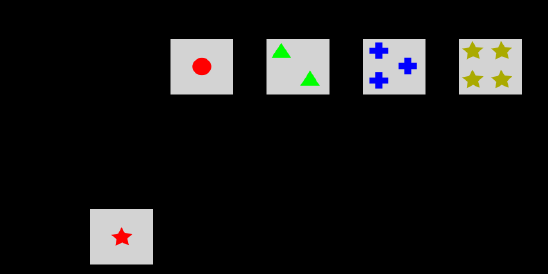
Figure 1. The computerized version of the WCST as offered by PsyToolkit [29]. A standardized collection of computerized cognitive tests. On the top of the image are the four different possible categories. On the bottom is the stimulus card presented to the user. The user is supposed to match the stimulus card to one of the categories by inferring the correct decision rule after the system’s feedback. In a complete session of the original WCST the user is given a total number of approximately 60 stimulus cards while the total number of categories remains always the